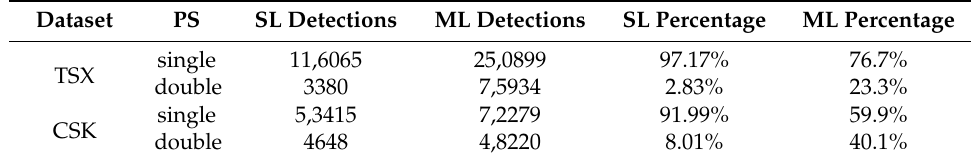
Table 2. Detected single and double PSs for single-look (SL) and multi-look (ML)